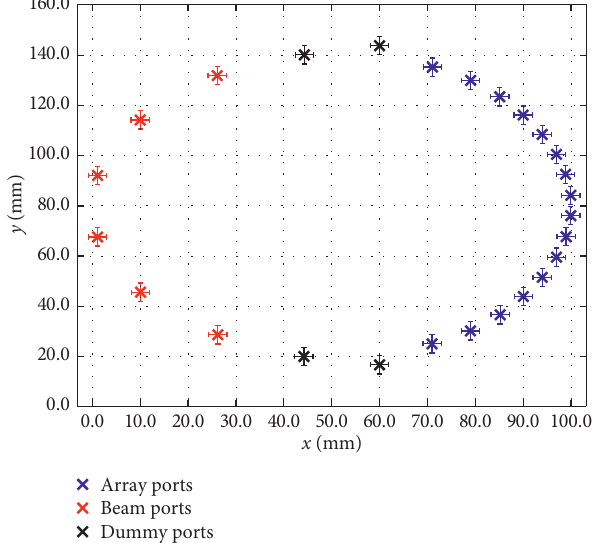
Figure 4: S-band Rotman lens